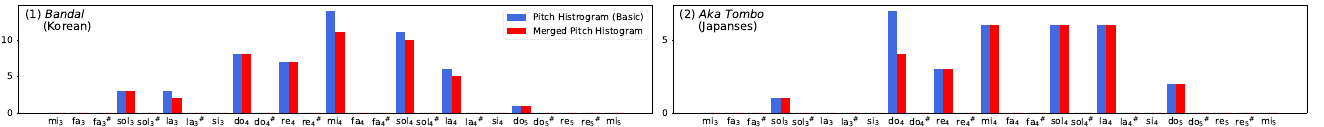
Figure 9. The movable do solfège-based basic and merged pitch histograms for four well-known East Asian traditional folk songs from cultural groups other than (Han) Chinese, with the lan- guages/cultural groups of the original version in curved brackets.